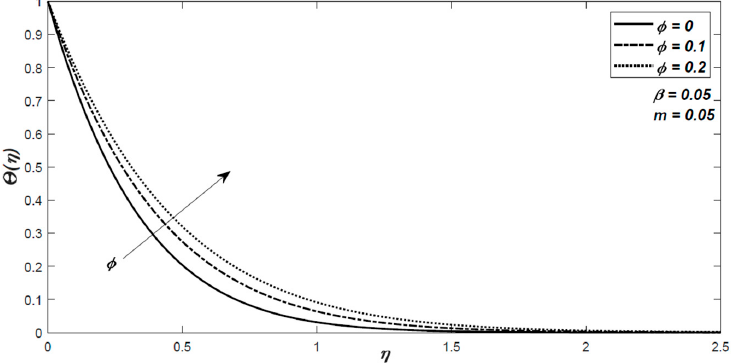
Figure 9. The variation of the nondimensional temperature for different values of volume fraction φ .